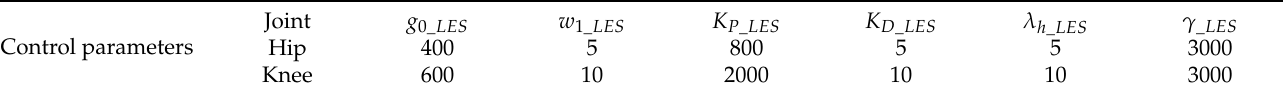
Figure 11. Single joint control block of the LES. Table 2. Parameters of the ILESO-PSMCs for the LES experiment.